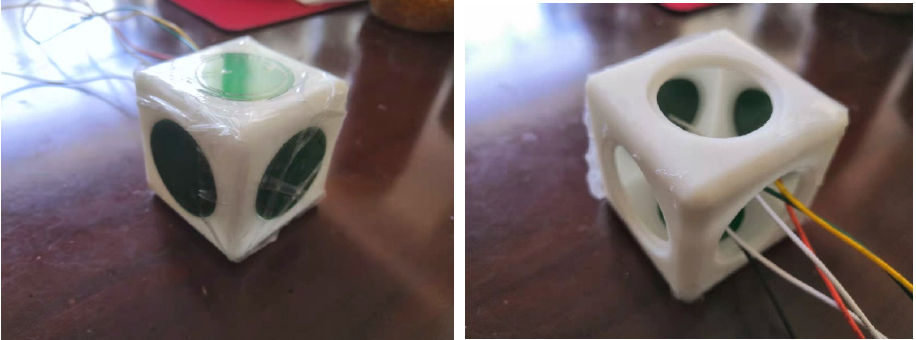
Figure 16. Three-dimensional electric field measurement system.